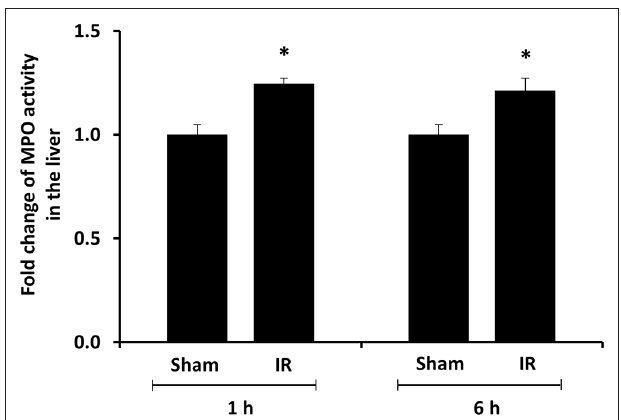
FIGURE 9 | Effect of kidney ischemia-reperfusion on myeloperoxidase activity in the liver. The left kidney of rats was subjected to 45min ischemia followed by 1 hour (1h) and 6 hours (6h) of reperfusion (IR). As a control, rats were subjected to a sham-operation without inducing ischemia (Sham). The myeloperoxidase (MPO) activity were determined in the liver. Results are expressed as fold change to the Sham. Results are expressed as mean ± SE ( n = 4–5 for each group). * p < 0.05 when compared with the value obtained from the sham-operated